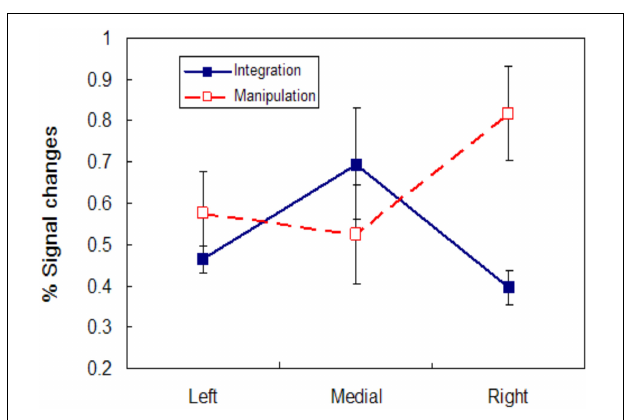
FIGURE 4 | Lateral and medial FPC activity during integration and manipulation. Mean peak activity represented as percent change of the BOLD signal in left, medial, and right FPC during the integrate sample (solid line) and manipulate condition change cue (dashed line). Mean maximum activation amplitude across subjects is plotted to assess processing in each region without influence from